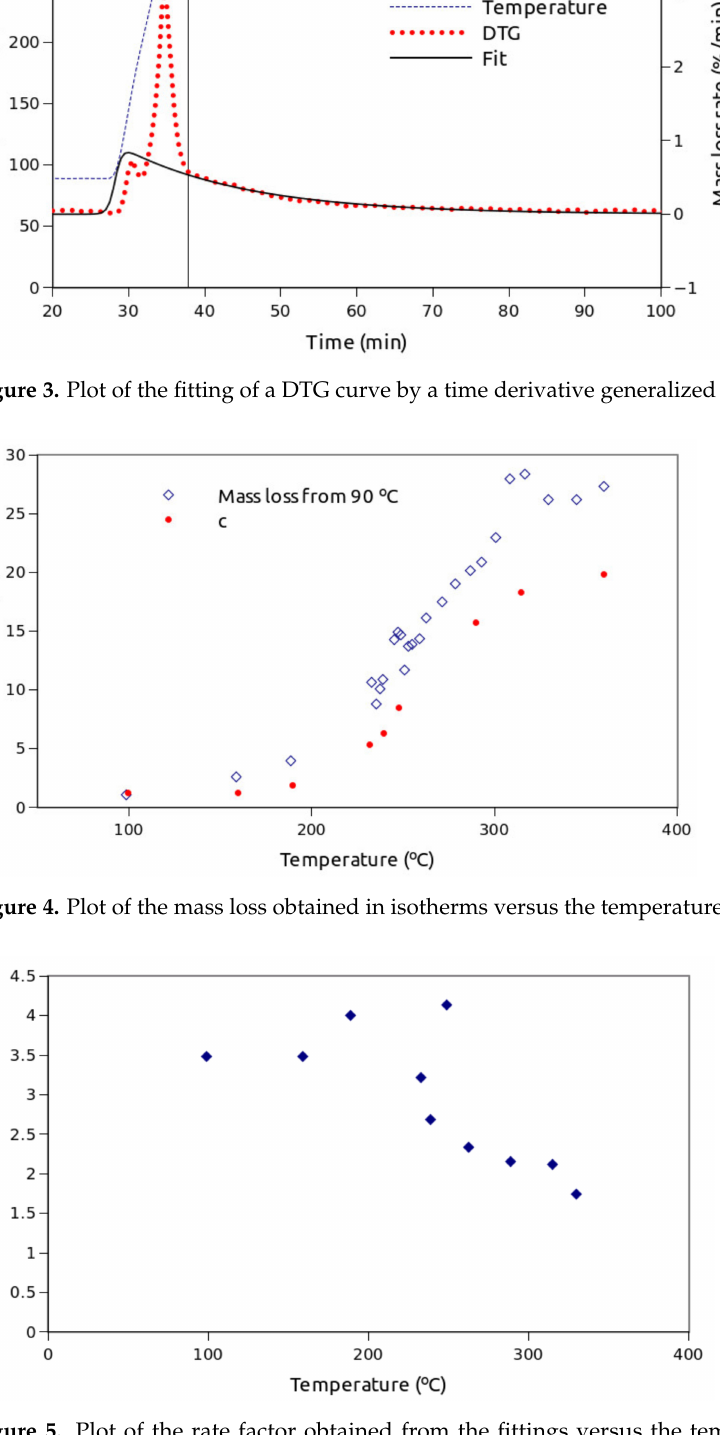
Figure 5. Plot of the rate factor obtained from the fittings versus the temperature at which the isotherms were